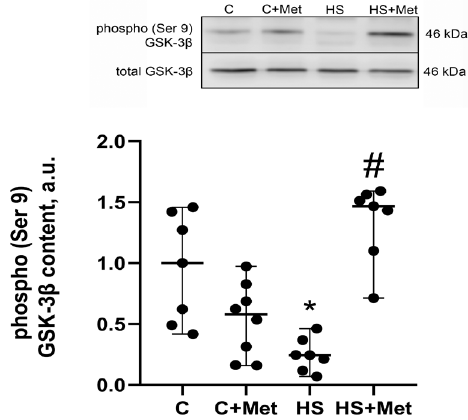
Figure 5. Effect of metformin pre-treatment on glycogen synthase kinase-3 β (GSK-3 β ) (Ser 9) phos- phorylation in rat soleus muscle. C, vivarium control, C+Met, vivarium control + metformin pre- treatment, HS, 7-day hindlimb suspension, HS+Met, metformin pre-treatment + 7-day hindlimb suspension. Data are shown as % of the C group. Scatter dot plot indicates median values, and the whiskers represent minimum and maximum values; n = 7–8/group. *: p < 0.05 vs. C, #: p < 0.05 vs. HS.